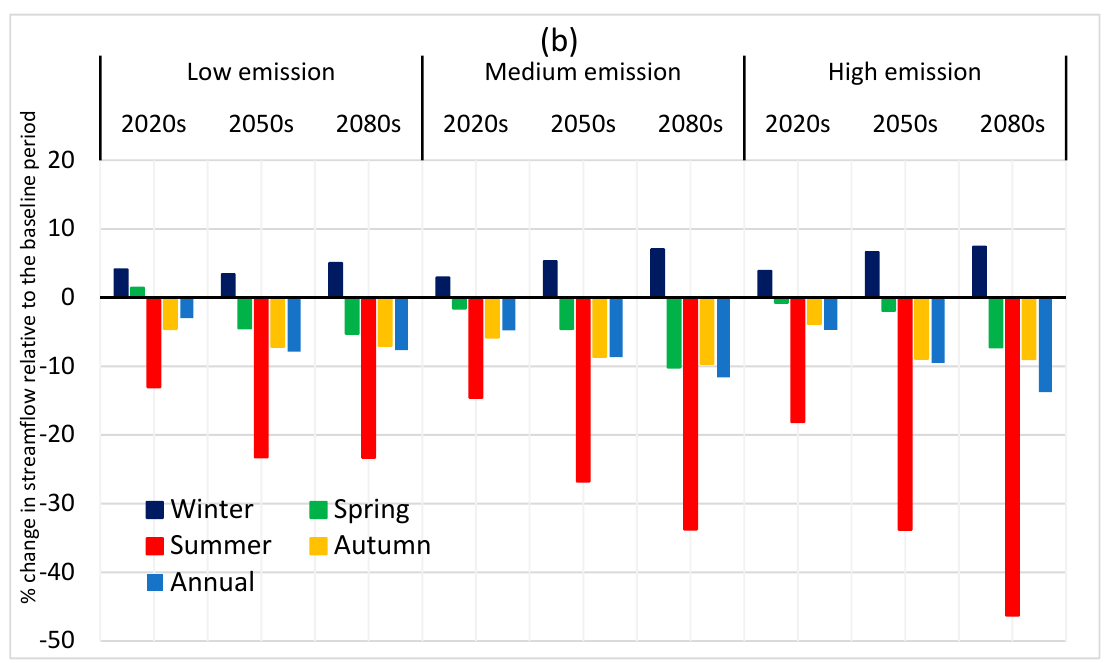
Figure 11. Changes in streamflow using joint probability ( a ) and weather generator ( b ) data of the UKCP09 different climate change scenarios.